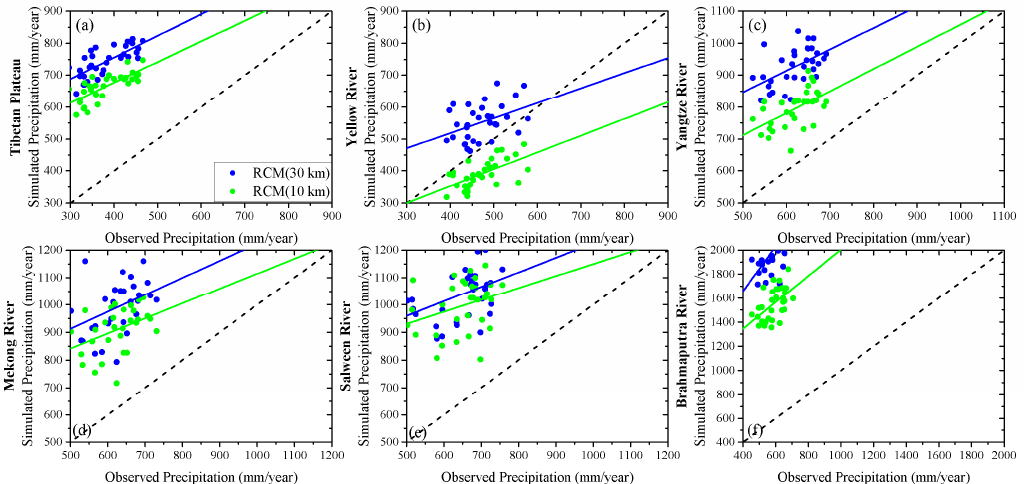
Figure 11. Same as Figure 10, but for precipitation. The whole TP ( a ) and five river basins (from b to f ) and during the period 1980 − 2010.